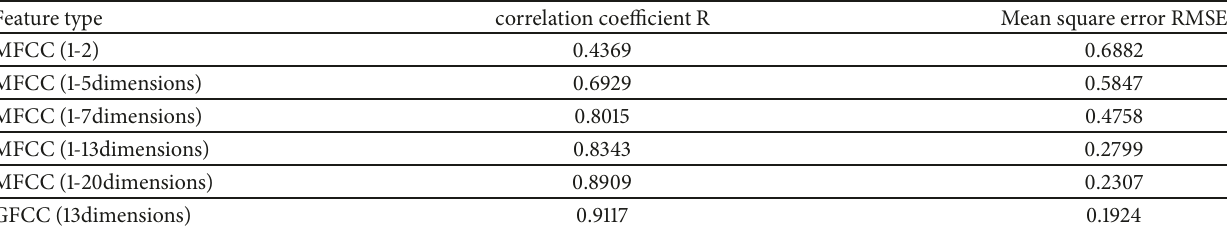
Table 3: The results of each index under different audio